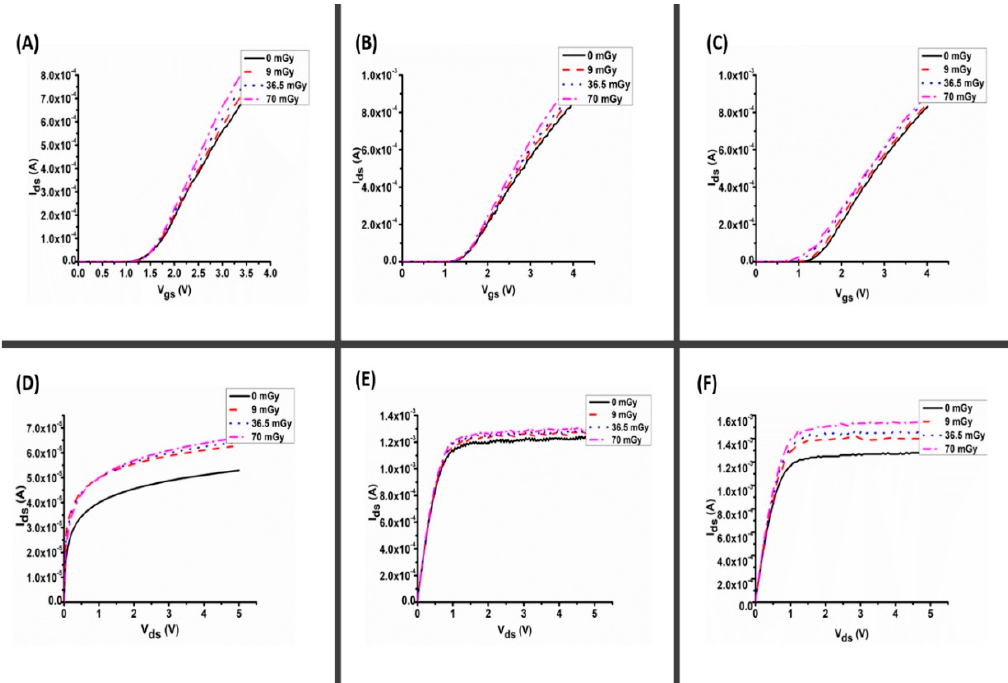
Figure 6. I–V characterization of AZO thick film for ( A – C ) transfer characteristics for bias voltage 0.3, 1 and 3 V, respectively, and ( D – F ) output characteristics for gate bias voltage 3, 5 and 7 V, respectively.